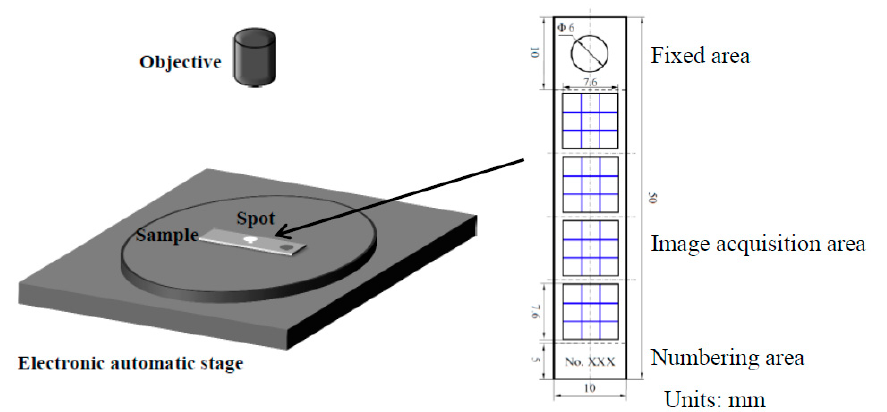
Figure 2. Schematic of image acquisition.